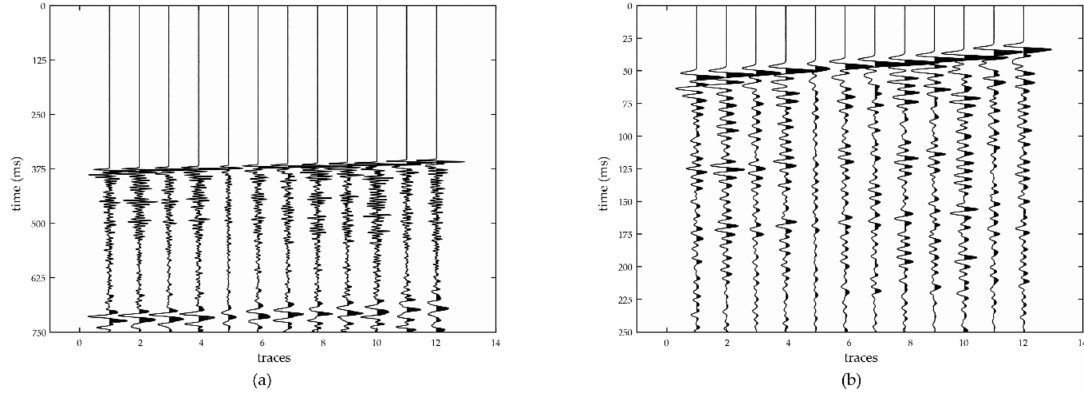
Figure 5. The waveforms of the microseismic event. ( a ) the P-wave and S-wave waveforms; ( b ) the P-wave record, which is a segment of the microseismic event from 325.25 ms to 575 ms. Four methods (AIC, cross-correlation, POC (STFT), and POC (WVD)) were used to estimate the relative arrival times of the P-wave record.